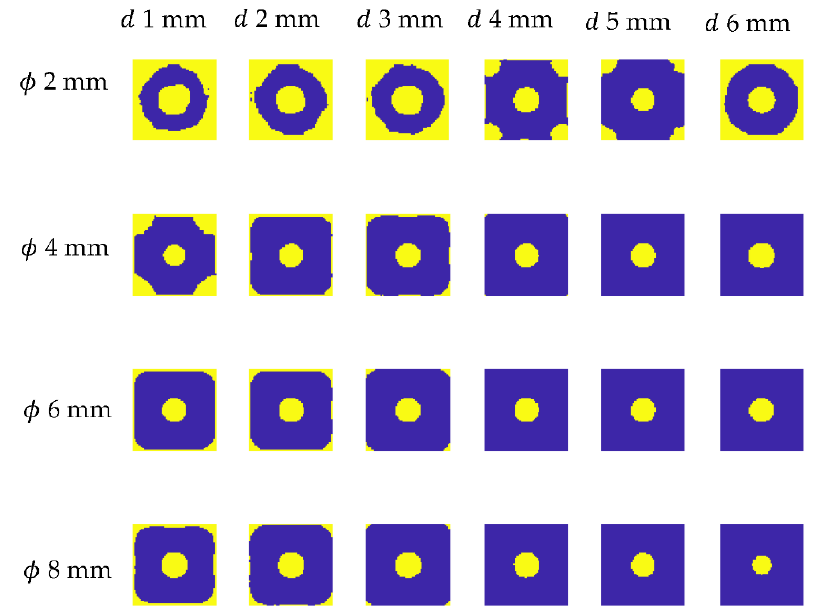
Figure 17. Exemplary results of the neural network classification executed on the numerical data shown for chosen defect diameter ( φ from 2 mm up to 8 mm) and depths ( d from 1 mm up to 6